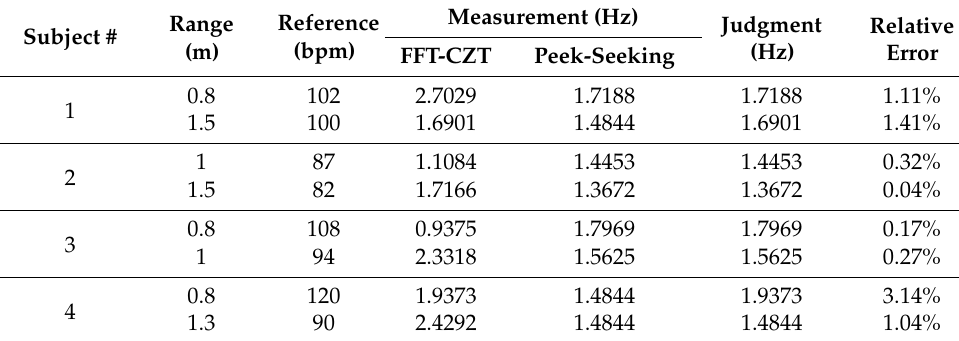
Table 4. Heart rate decision result of group